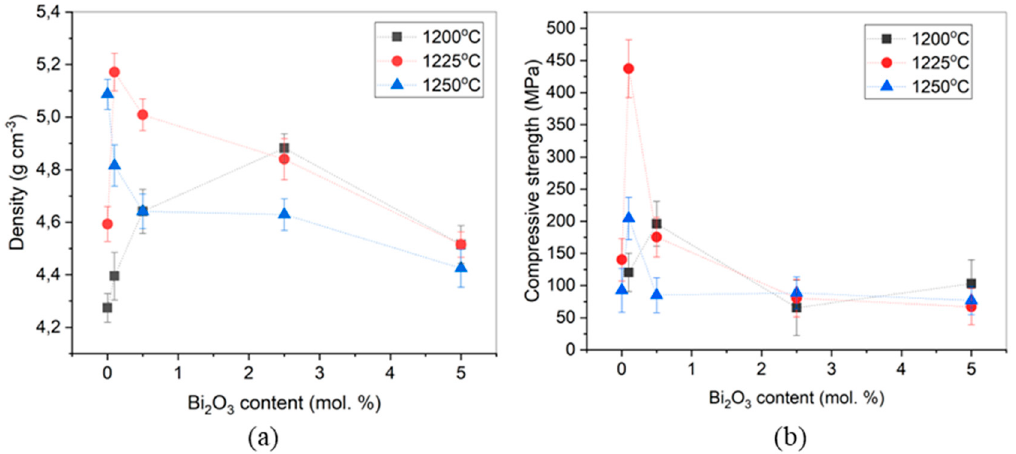
Figure 6. Relative density ( a ) and compressive strength ( b ) of BaTiO 3 ceramics sintered at 1200–1250 °C with different contents of Bi 2 O 3 additive.